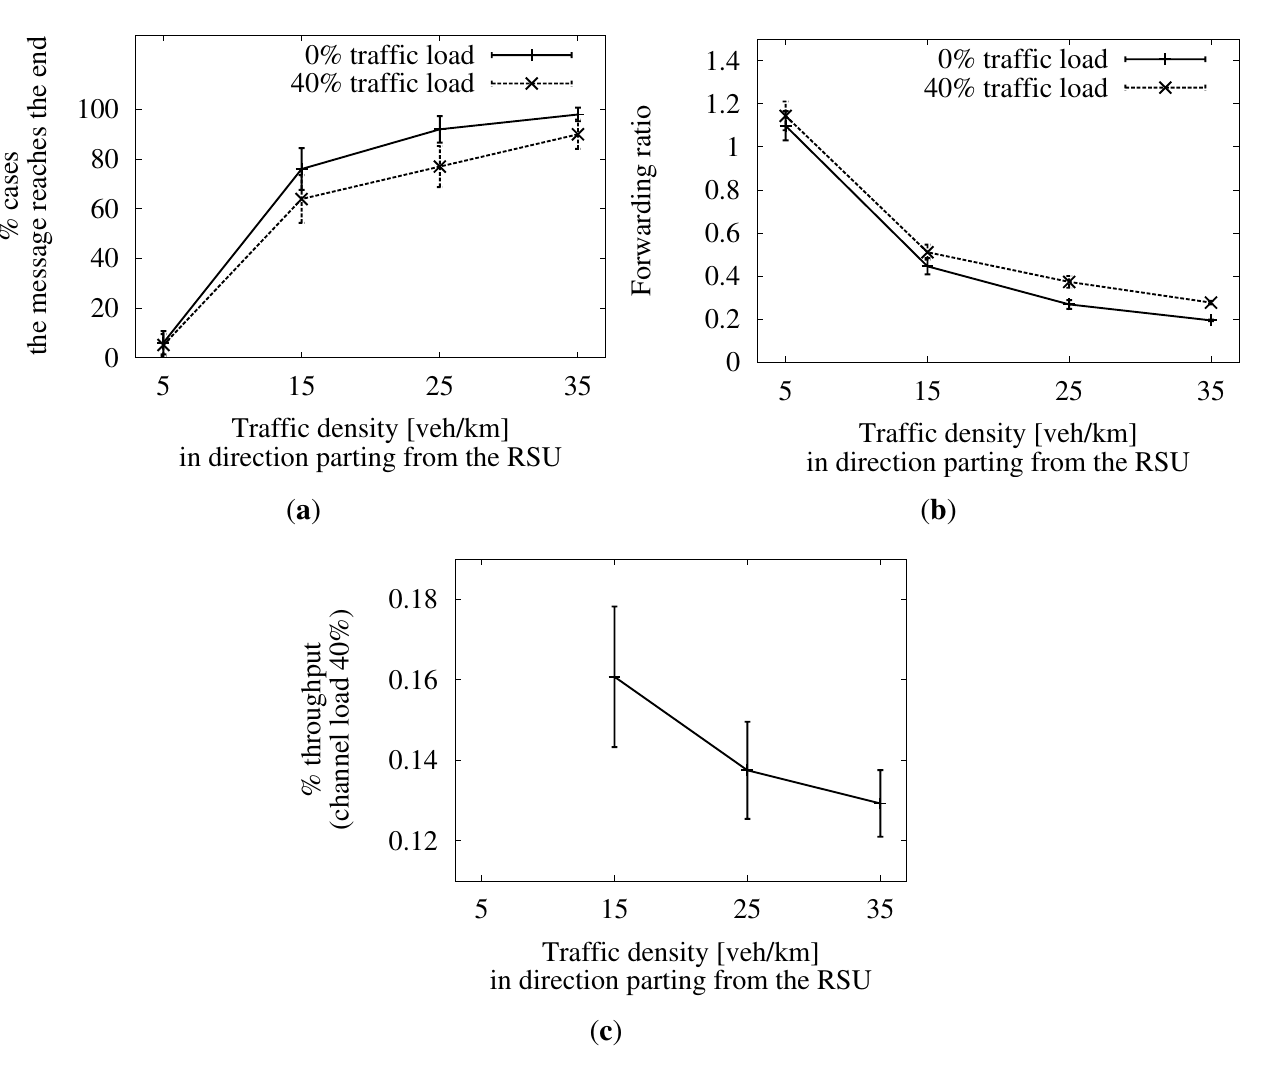
Figure 15. Performance when the wireless channel is loaded to 40%. Confidence interval of